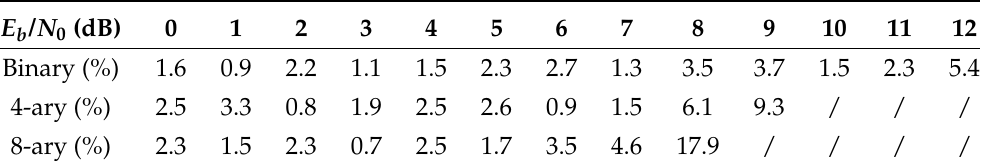
Tables 3 and 4 demonstrate the errors for optimal receiver in noncoherent PPM system. The results are similar to that of suboptimal receiver. Table 3. The errors between the BER performance and the theoretical results of optimal receiver (100 × 10 3 PPM symbols).